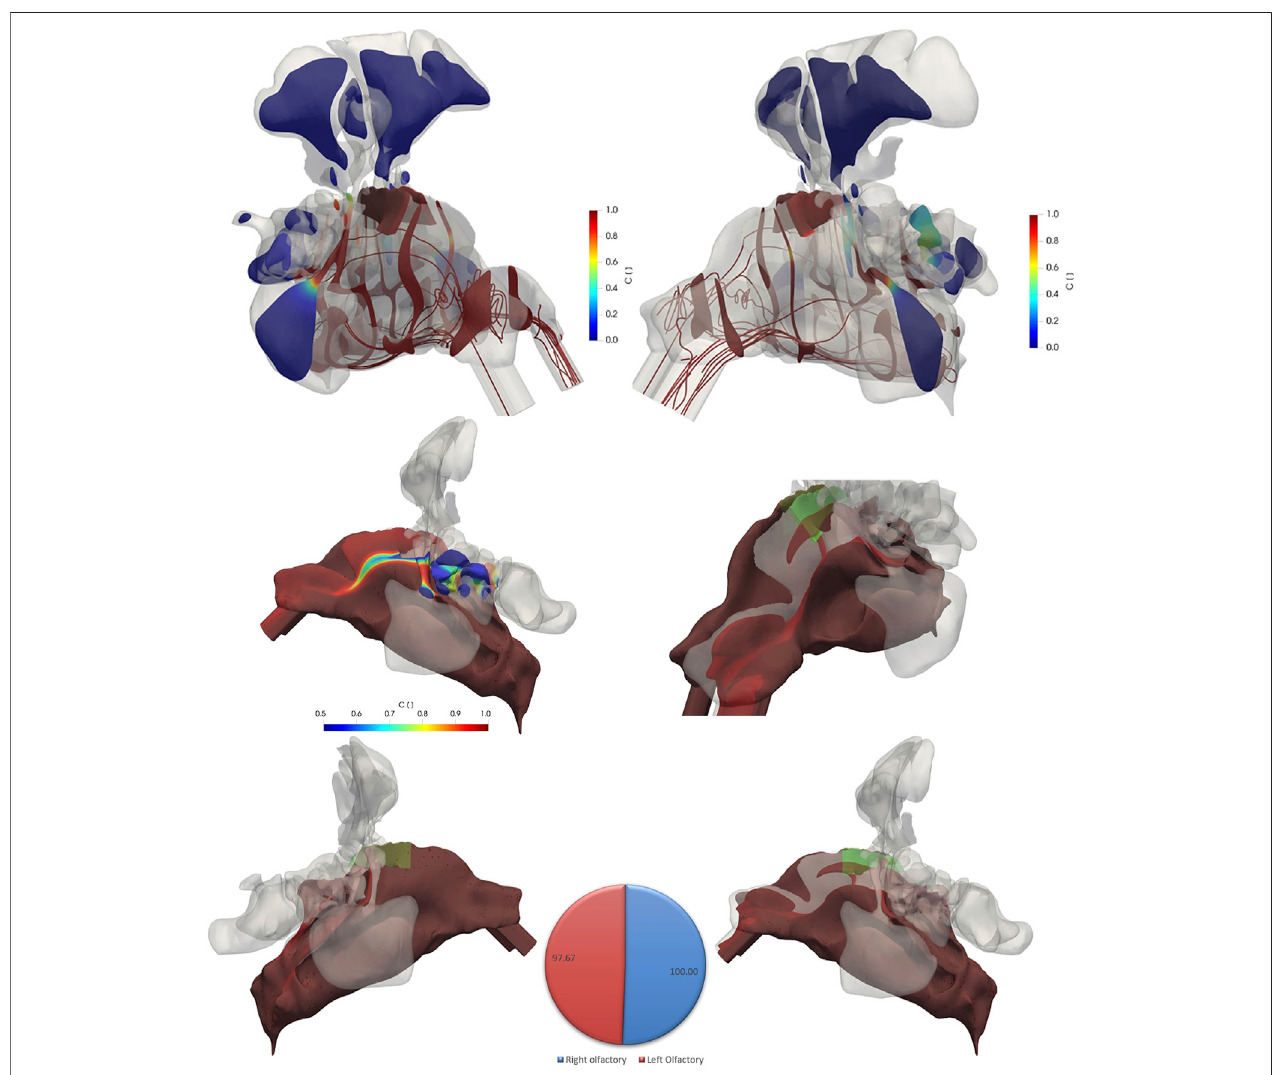
FIGURE 6 | The contour plots of variable C (drug-laden air fraction) and fl ow streamlines (color coded for C) in different regions of the nasal cavity speci fi cally in the olfactory region (green shaded) at t (cid:2) 1.98 s (end of delivery phase) for the non-pulsatile inlet fl ow rate of 4 L/min (top fi gures). The fi gures at the bottom show the iso- volumesofvariableCforvaluesmorethan0.99fromleftandrightviewsaswellasclose-upviewoftheleftcavity.Aniso-volumeofvariableCwithvaluesmorethan0.5is shown in the middle fi gure for a better visualization of values. The Pie chart shows the volume weighted value of C in the left and right olfactory regions. The green shaded regions in the bottom fi gures represent the olfactory region.